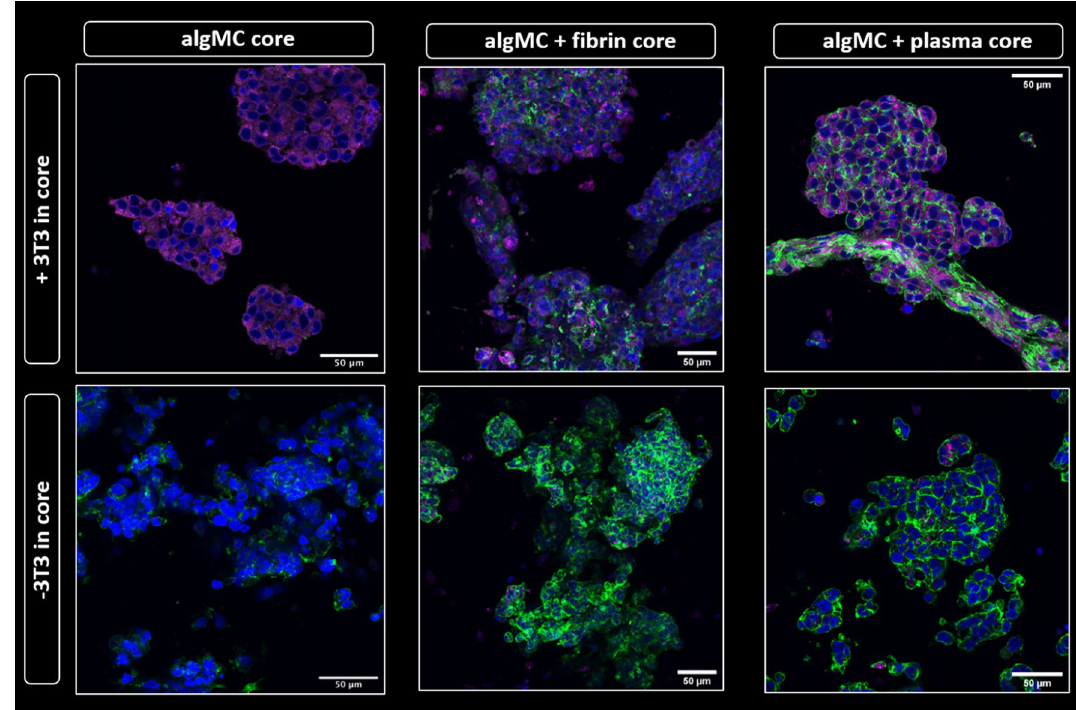
Figure 13. Albumin expression of HepG2 clusters formed in shell compartment in co-culture with NIH 3T3 embedded in core compartment (upper panel) and in monoculture (cell-free core; lower panel). In both, co-culture and monoculture, the core was composed of algMC, algMC + fibrin and algMC + plasma. Confocal images of HepG2 stained for Albumin (purple), nuclei (blue) and cytoskeletons (green); scale bars represent 50